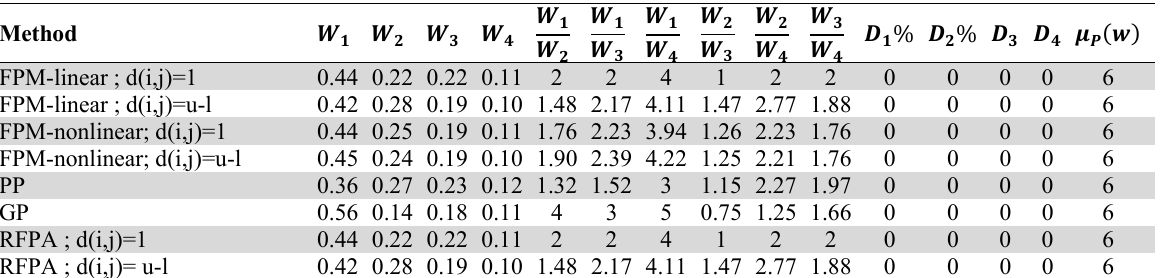
Four-dimensional consistent judgments